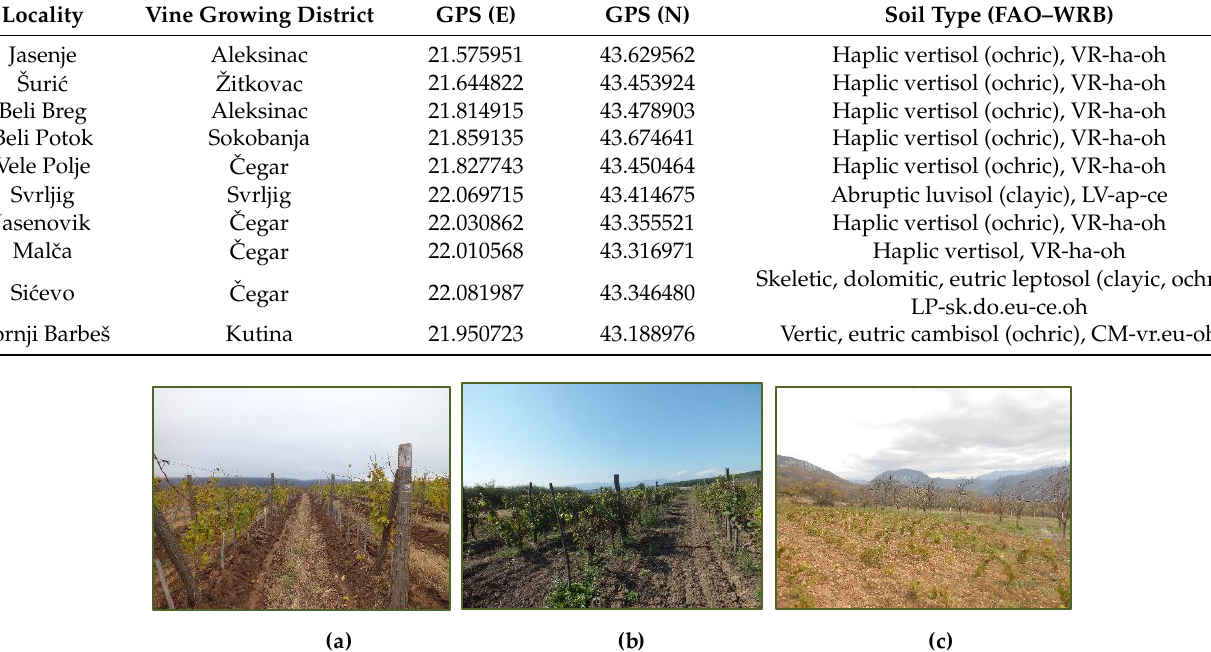
Table 1. Locations, vine growing districts, global positioning system (GPS) coordinates and soil types of the vineyards. Locality